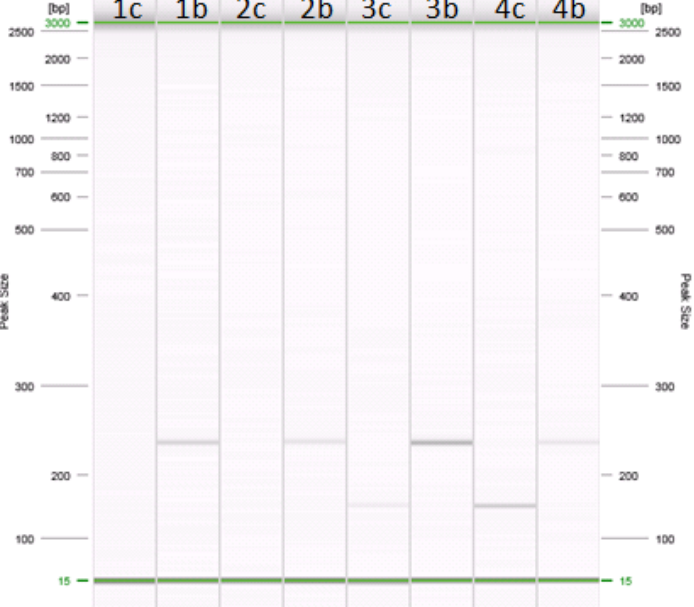
Figure 1. Amplification of cow and buffalo specific primers in PCR. Lanes: (1c–b) 0.1% cow in buffalo mozzarella cheese; (2c–b) 0.5% cow in buffalo mozzarella cheese; (3c–b) 1% cow in buffalo mozzarella cheese; (4c–b) 5% cow in buffalo mozzarella cheese. Samples in lanes 1c, 2c, 3c, and 4c were amplified with primers specific for cow (about 147 bp). Samples in lanes 1b, 2b, 3b, and 4b were amplified with primers specific for buffalo (about 226 bp).